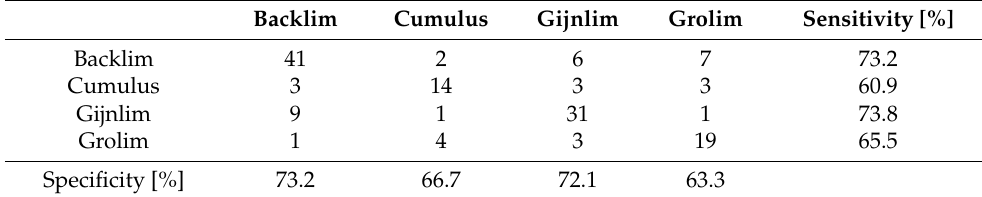
Table 2. Confusion matrix for the classification of the botanical